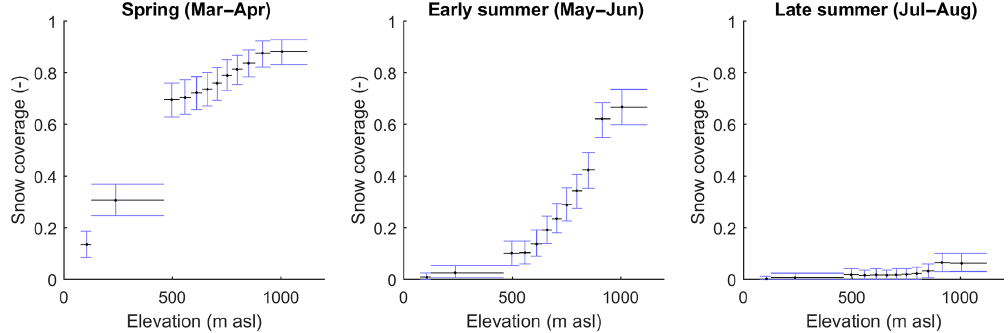
Figure 6. Snow coverage curves defined from the MOD10A1 snow cover product from 2000 to 2015 with 95% confidence bounds.